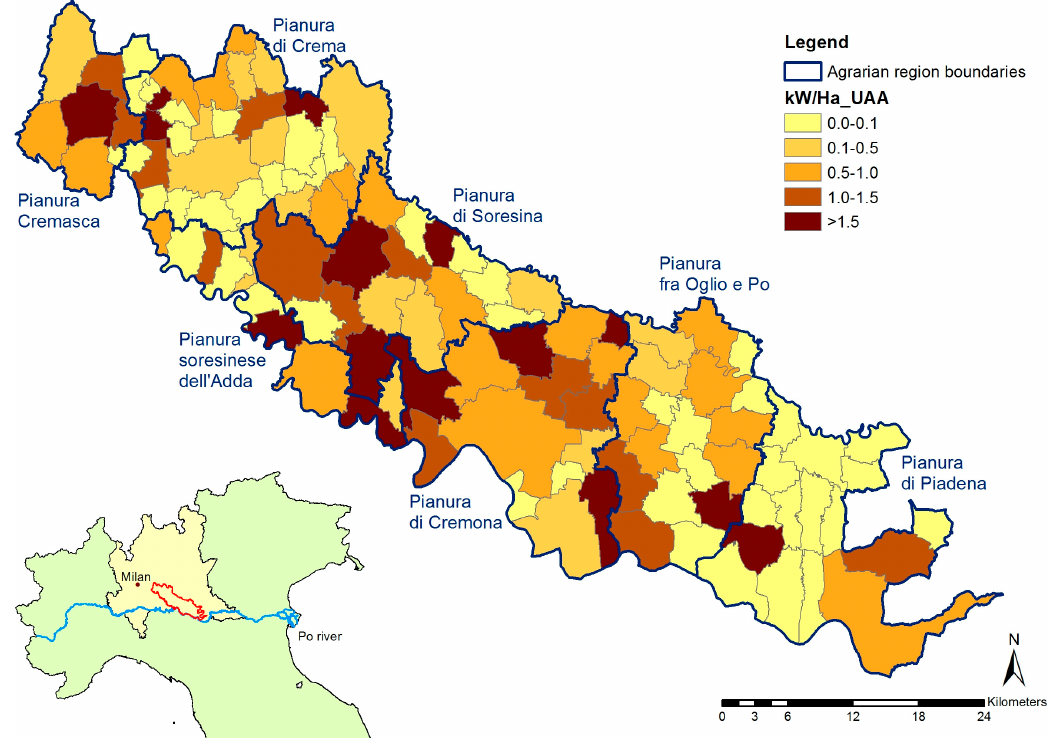
Figure 1. The Province of Cremona in the Lombardy Region and the distribution of biogas plants in the area.